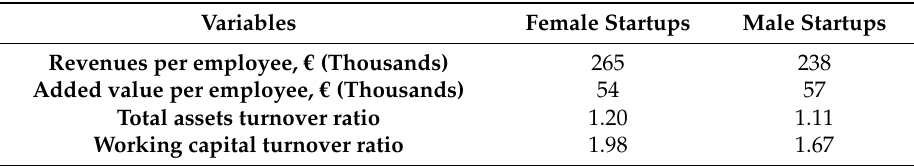
Table 7. Operational efficiency.